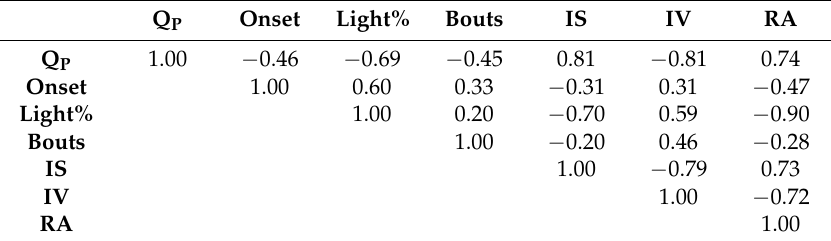
Table 2. Interrelation between different circadian disruption